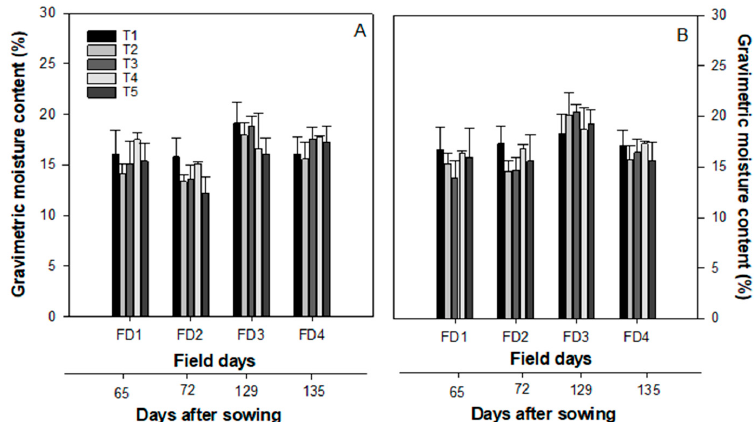
Figure 3. Temporal variations and effects of different soil amendments on gravimetric moisture content of soil at 0–10 cm ( A ) and 10–20 cm ( B ) depth in podzolic soils under various nutrient management practices. Each vertical bar represents mean whereas bar errors show ± standard error of three replications.